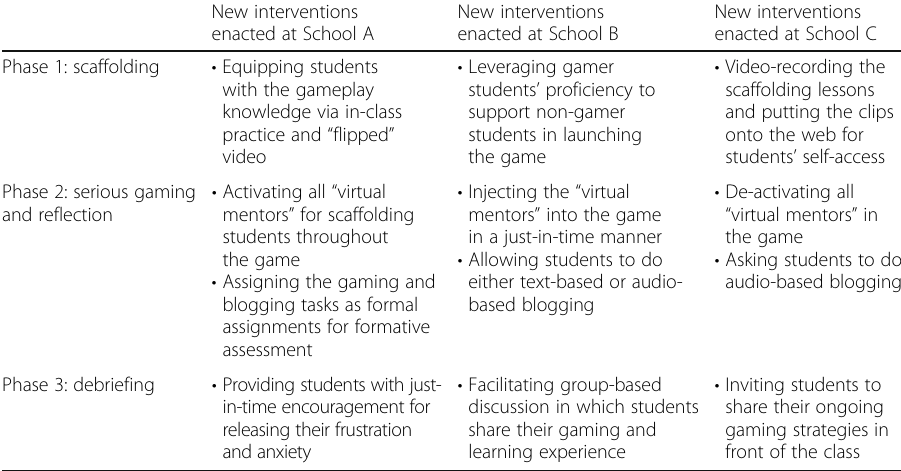
New interventions enacted at School B